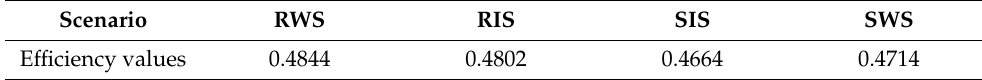
Table 5. Carbon efficiency values under carbon peaking.